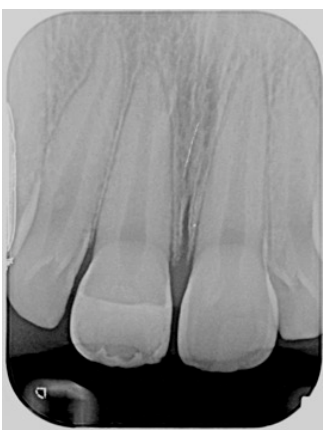
Figure 19. Five years post-operative x-ray.